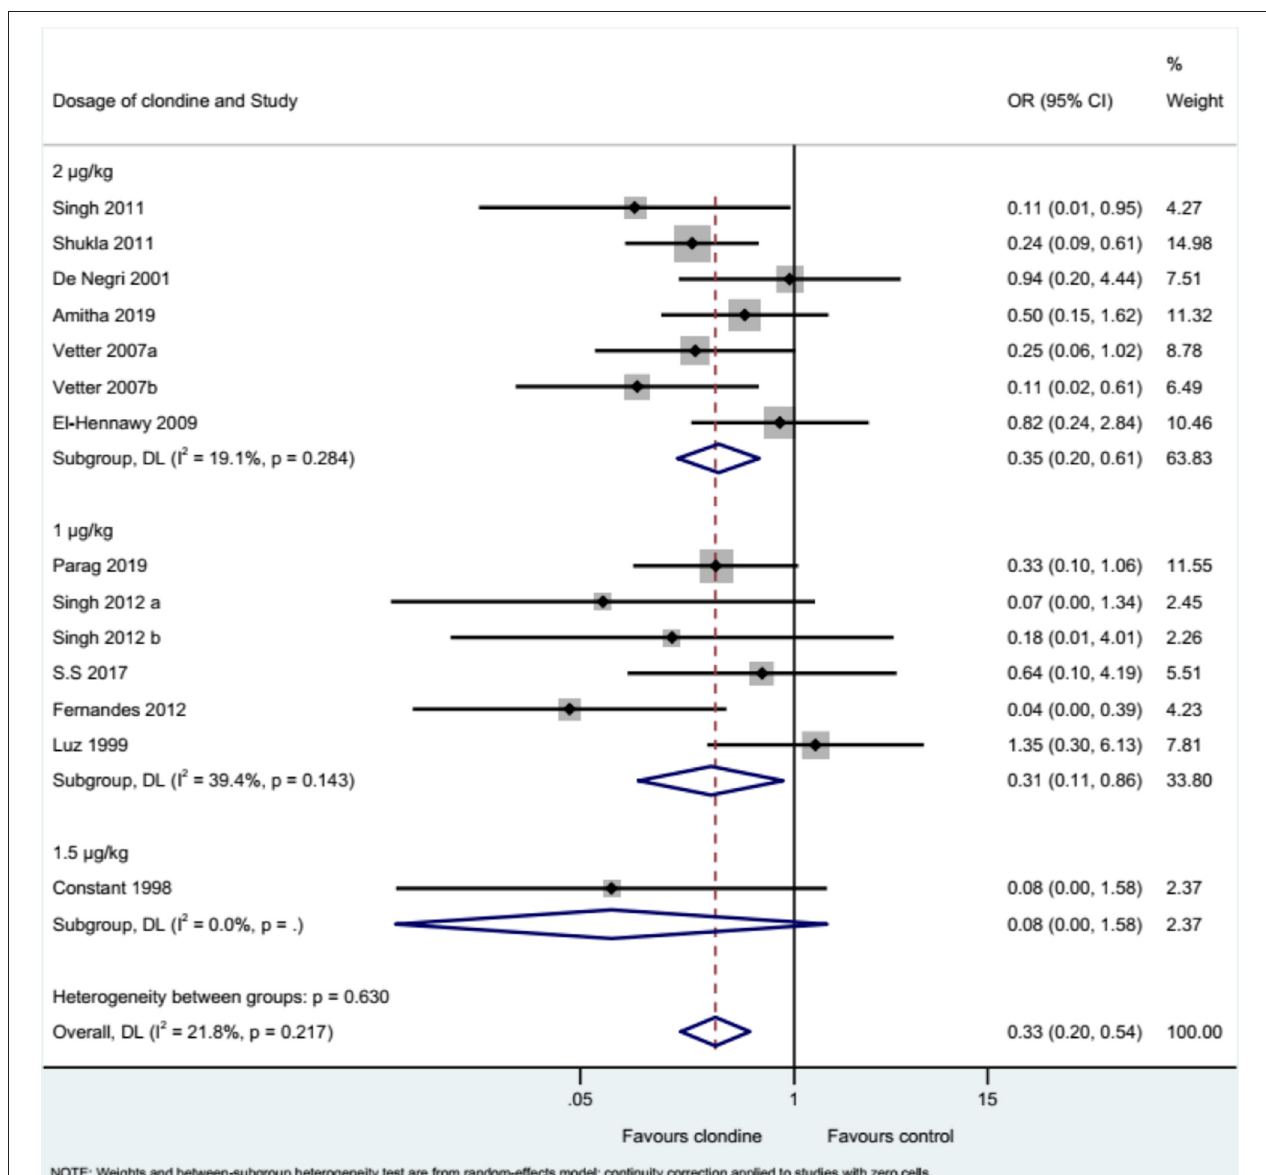
FIGURE 14 | Subgroup analysis of complications by the dosage of